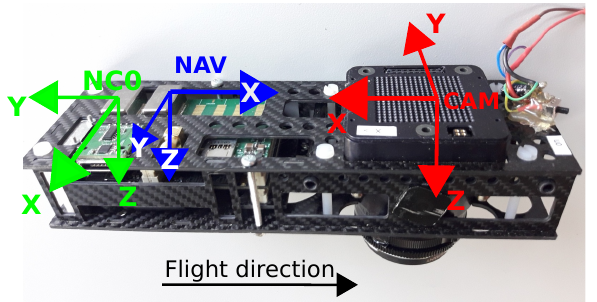
Figure 2. Carbon mount holding the camera, board with 2 IMUs and an embedded PC plus highlighted coordinate frames: (i) green: the physical body-frame of IMU denoted NC0, (ii) blue: the chosen navigation frame for IMU NC1, (iii) the chosen camera-frame with x − y plane spanning image coordinates.